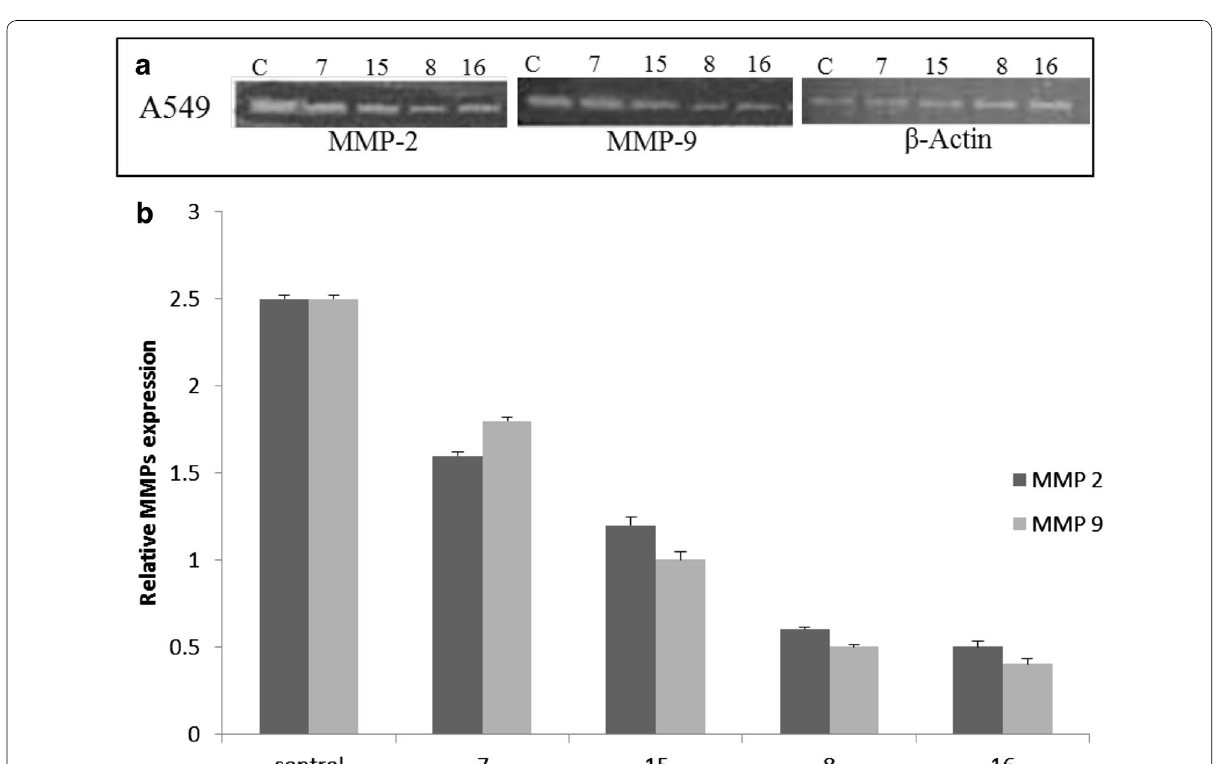
Fig. 3 a , b Relative mRNA expression of gelatinases MMPs shows a down regulation in collagen degrading enzymes upon treatment. c Control; Compounds 7 (8.5 µM), 8 (7.7 µM), 15 (8.2 µM), and 16 (7.3 µM). Data are illustrative of a minimum of three independent